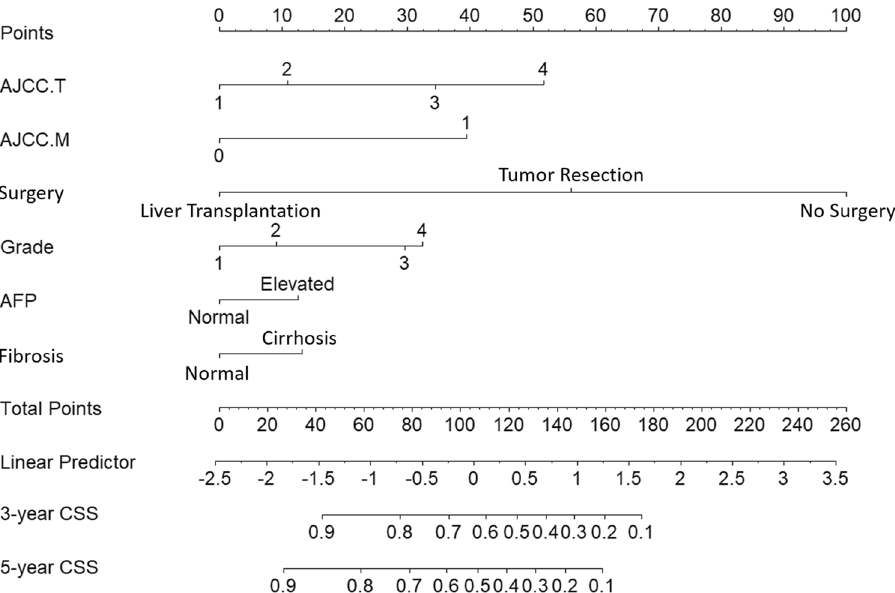
Figure 1. The nomogram predicting CSS in patients with HCC. Each factor was given a point on the basis of the nomograms. The total points were obtained by adding the given points of all factors. The estimated 3- and 5-year probabilities of CSS of the individual patient can be easily obtained from the nomogram based on the total points.